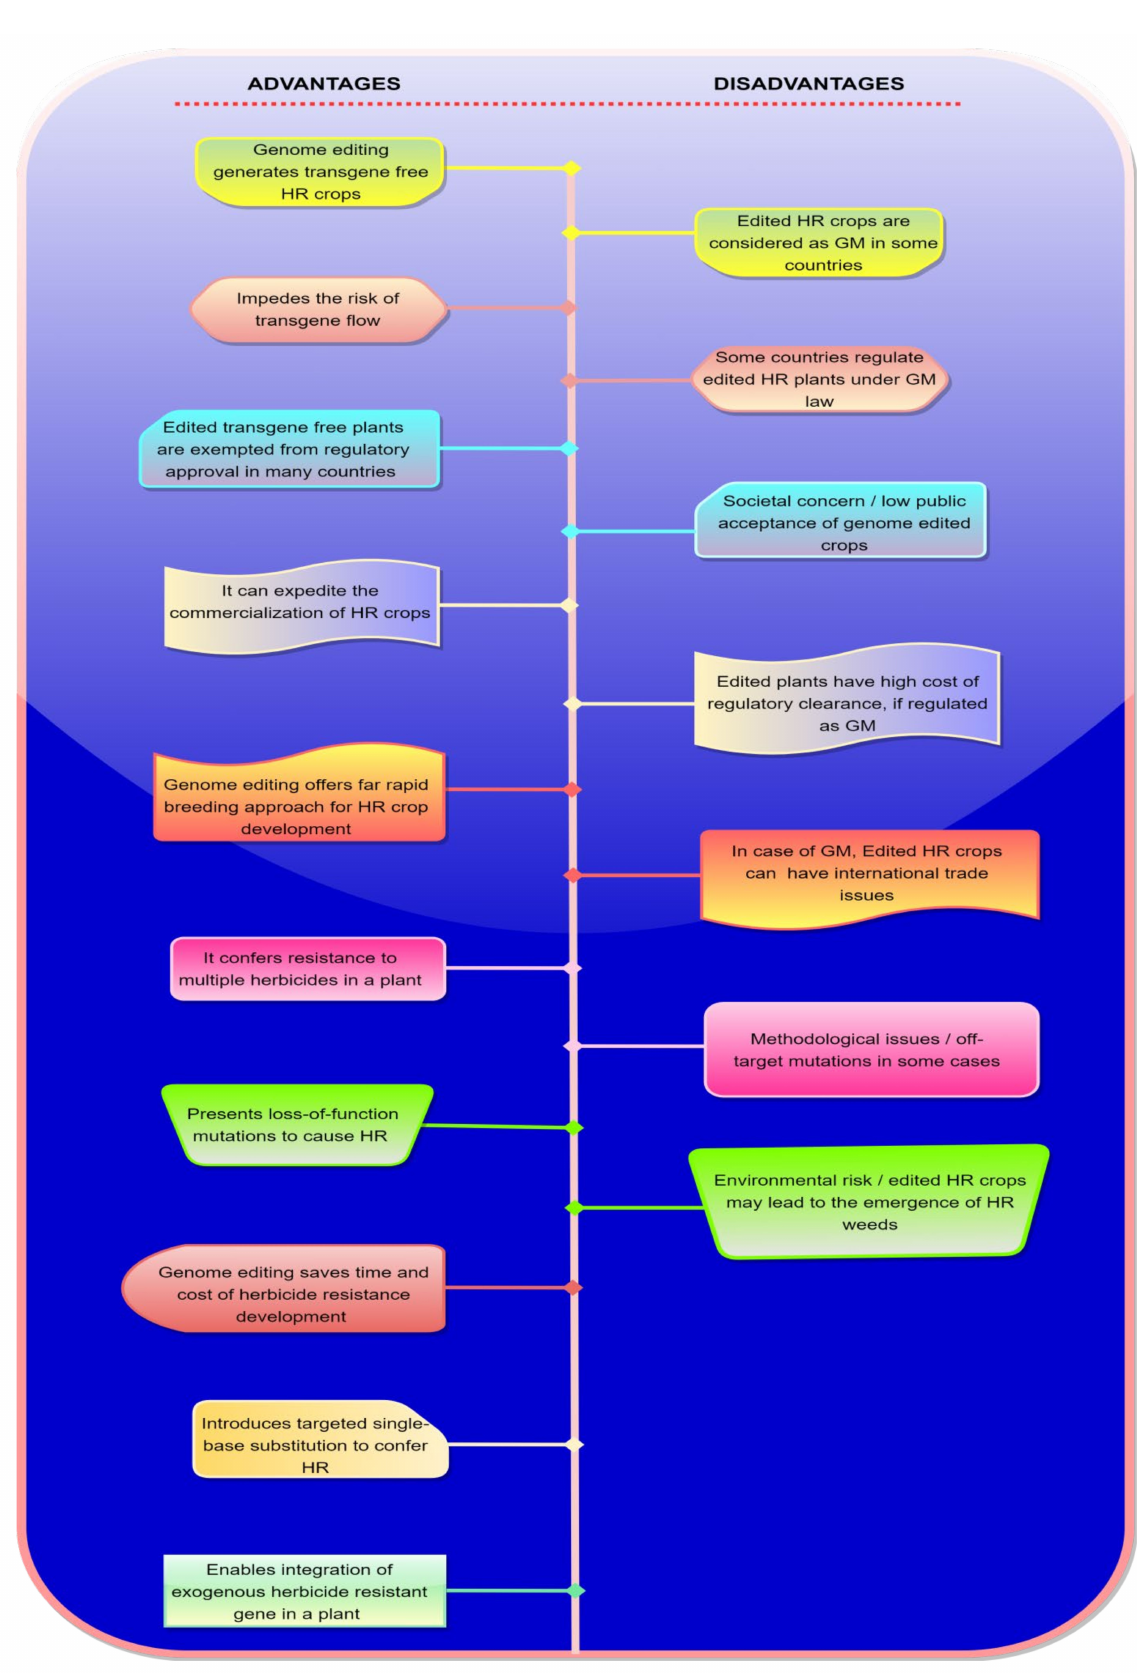
Figure 4. Advantages and disadvantages of genome editing in herbicide resistance. HR: Herbicide resistance, GM: Genetically